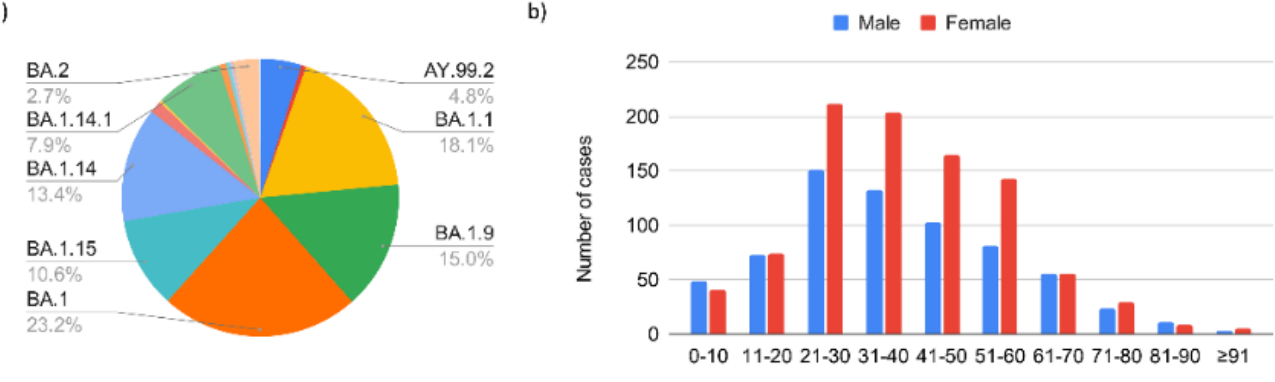
Figure 6. Epidemiological evaluation of SARS-CoV-2 during the Omicron epidemic wave. The data are distributed according to: ( a ) Omicron sublineages; ( b ) demographic characteristics of the positive patients divided by sex and age.